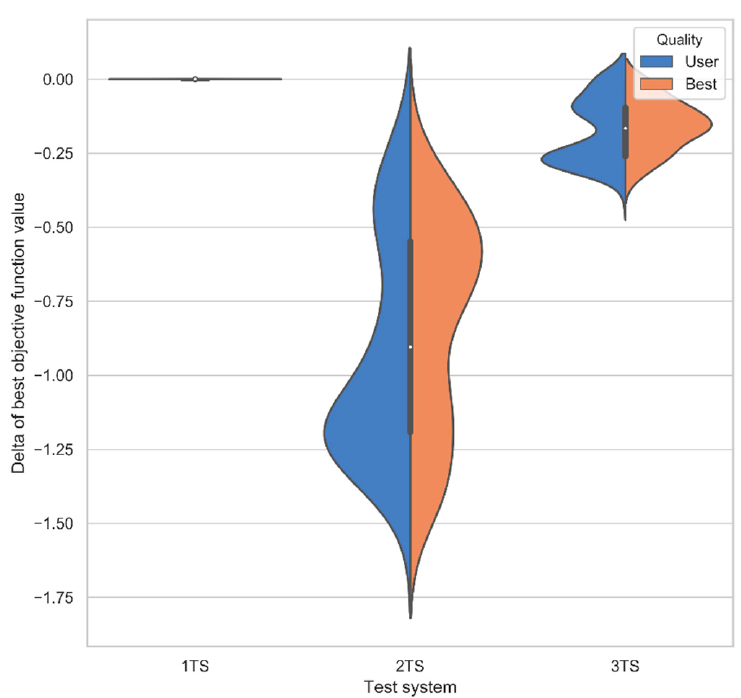
Figure 12. Violin plots for the resultant objective function value deviations from the initial points for the test cases under consideration calculated using the very fast simulated annealing method with user-defined (1TS: C = 2.19, F = 1.75; 2TS: C = 1.50, F = 1.75; 3TS: C = 2.00, F = 3.78) and optimal (1TS: C = 1.44, F = 1.93; 2TS: C = 2.27, F = 3.79; 3TS: C = 2.75, F = 3.12) parameters.